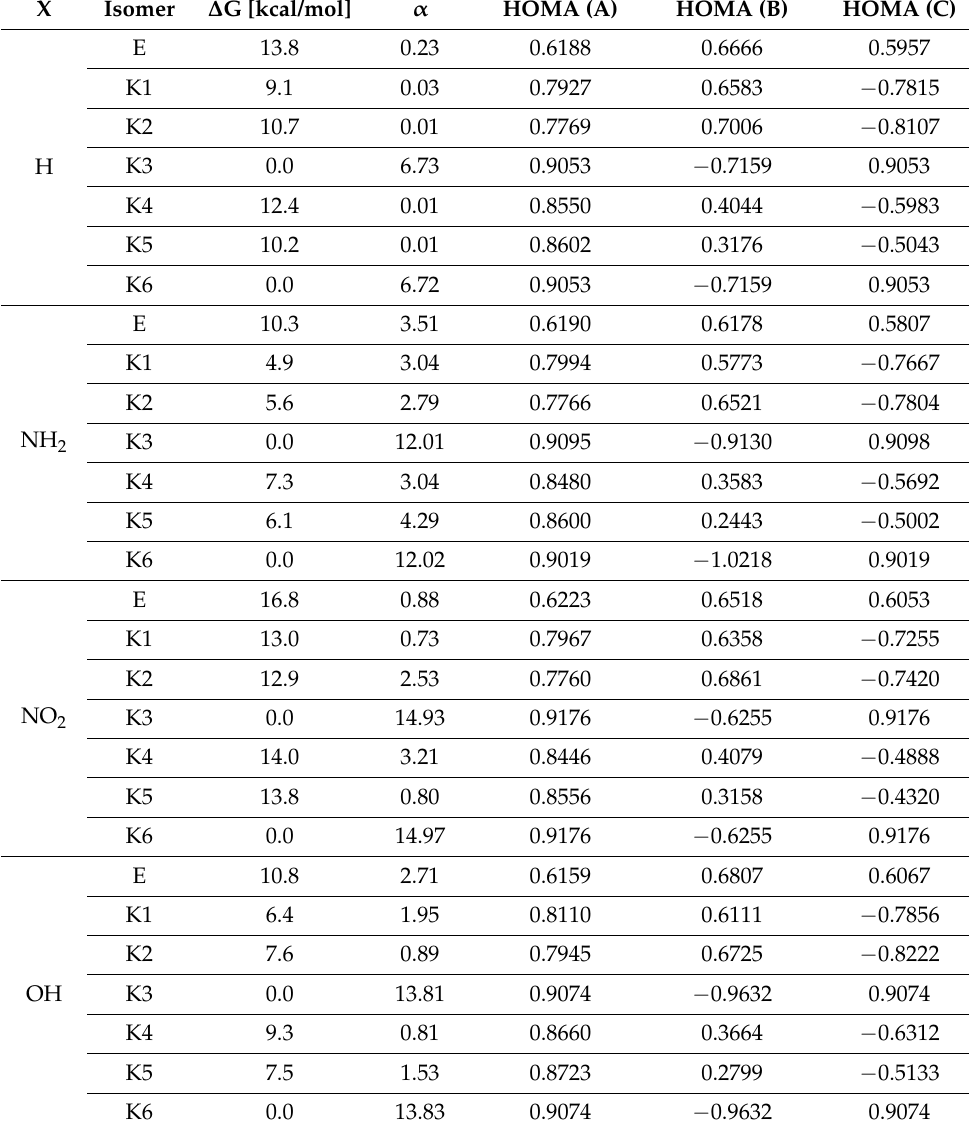
Table 1. G at 298 K, α and HOMA parameter for optimized